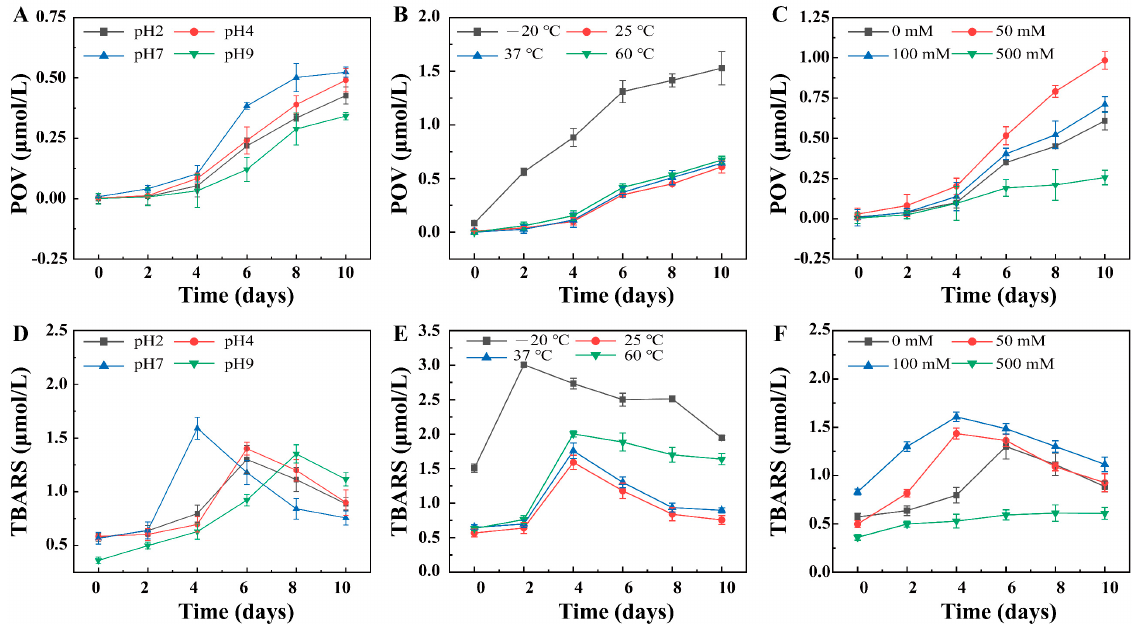
Figure 4. Chemical stability of the Pickering emulsion under different environmental stresses. ( A – C ) Peroxide value (POV) and ( D – F ) thiobarbituric acid reactive substance (TBARS) of the Pickering emulsion under different pH, temperature, and salt concentration conditions.